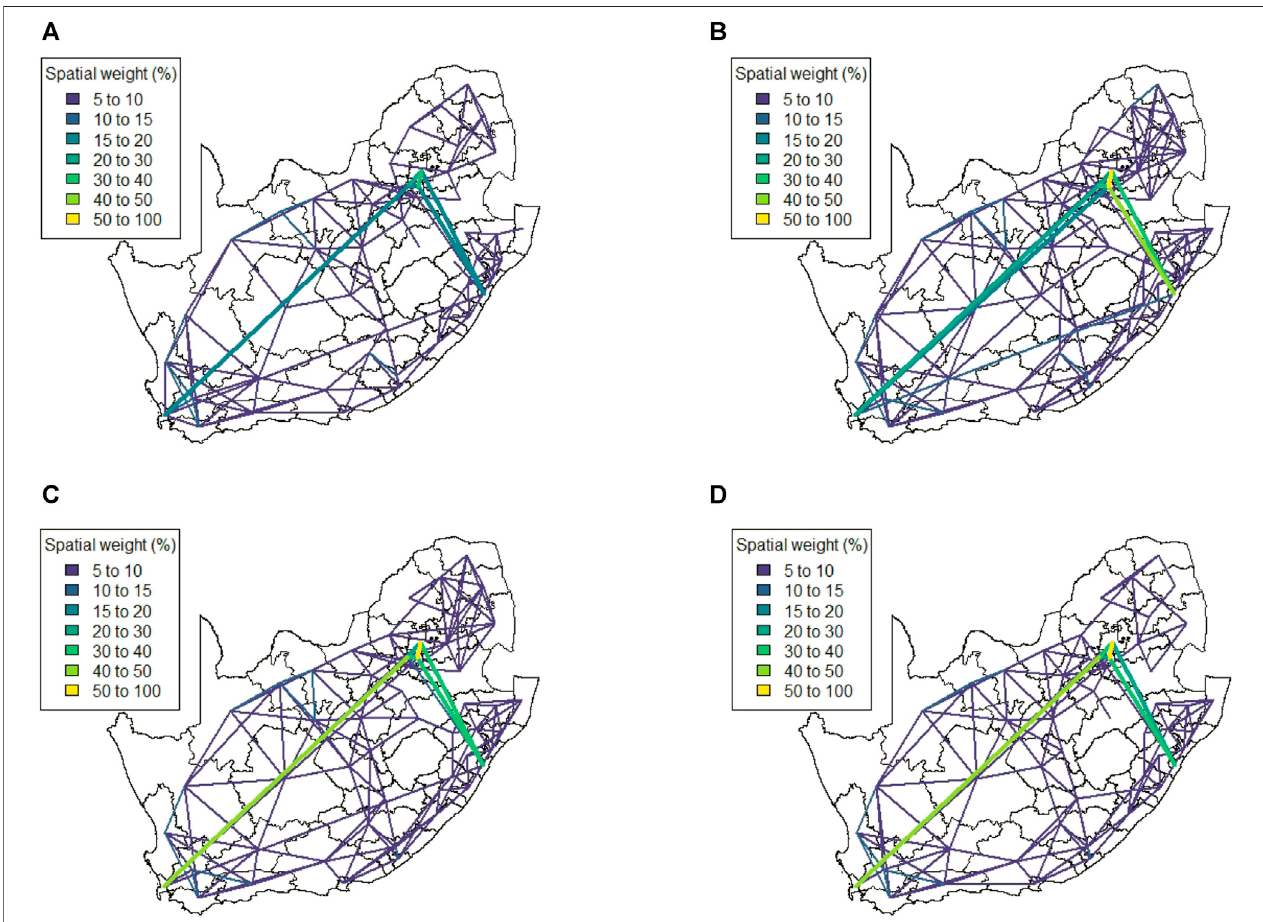
FIGURE 9 | Method 3 spatial weight matrix entries (weights ≤ 5 not shown) (A) Business as usual, (B) Level 5, (C) Level 4, and (D) Level